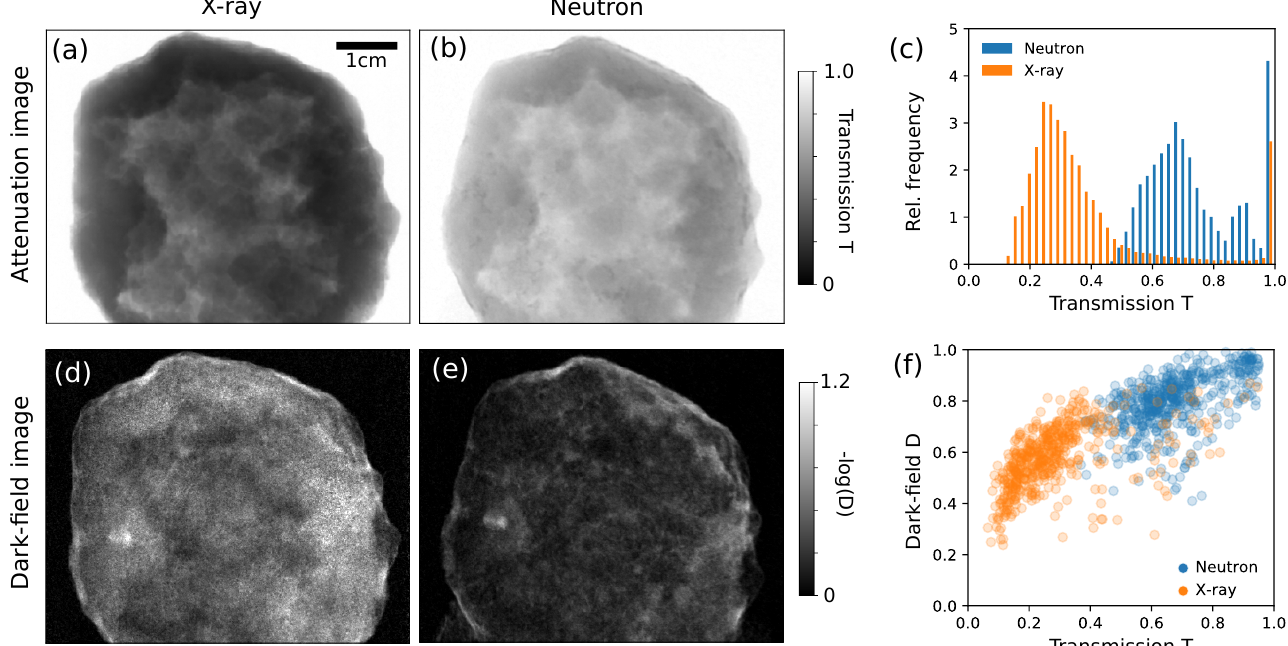
Figure 3. Quantitative comparison of an angular projection of the quartz geode. X-ray attenuation image ( a ) at 70kVp, neutron attenuation image ( b ) at 1.6Å and histogram of the grey values of both images ( c ). X-ray dark-field image ( d ), neutron dark-field image ( e ) and a scatter plot ( f ) showing the ratio of attenuation and the dark-field related visibility loss of 500 random pixels from all